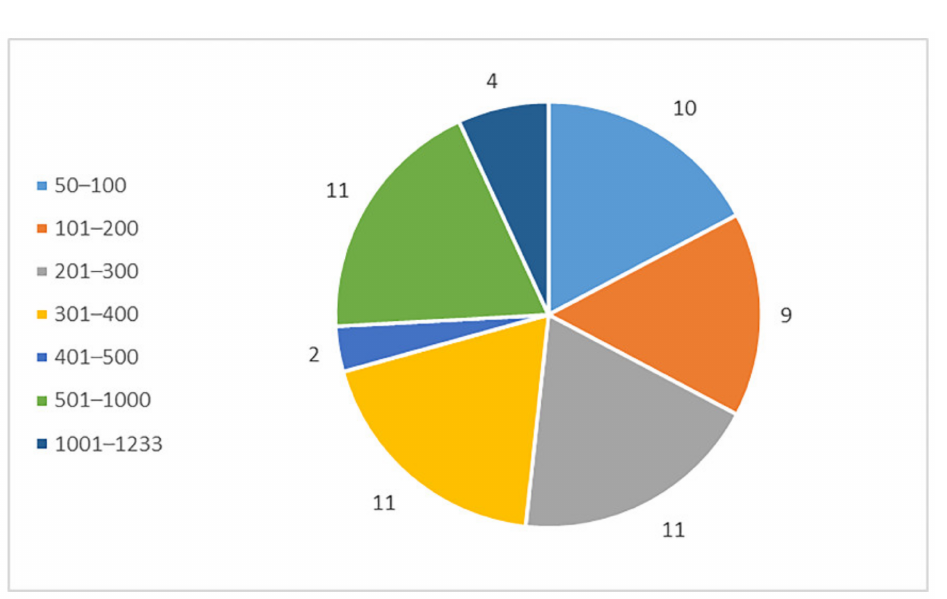
Figure 2. Distribution of the protein lengths of